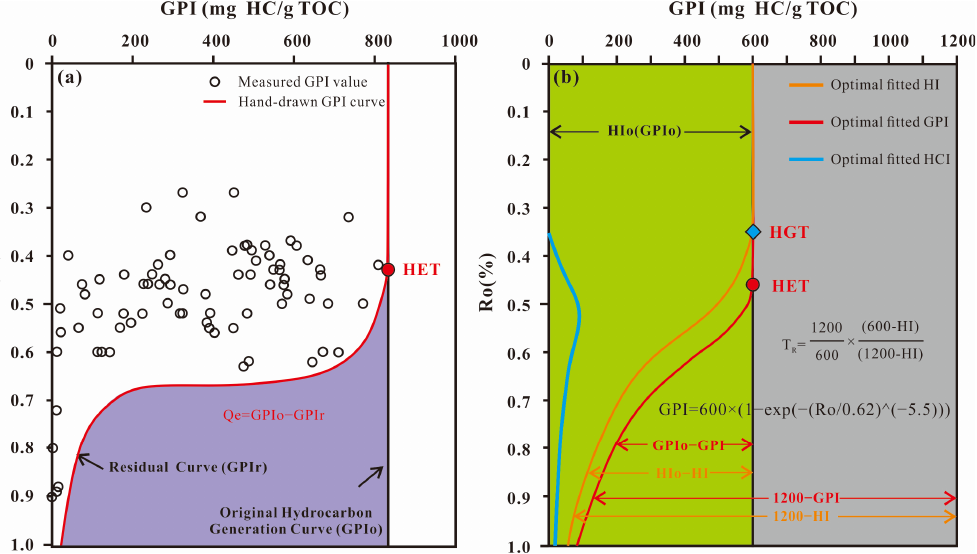
Figure 13. Comparison between the traditional HGE model ( a ) and the quantitative optimized model ( b ) of the Es4 source rocks in the Niuxintuo area.